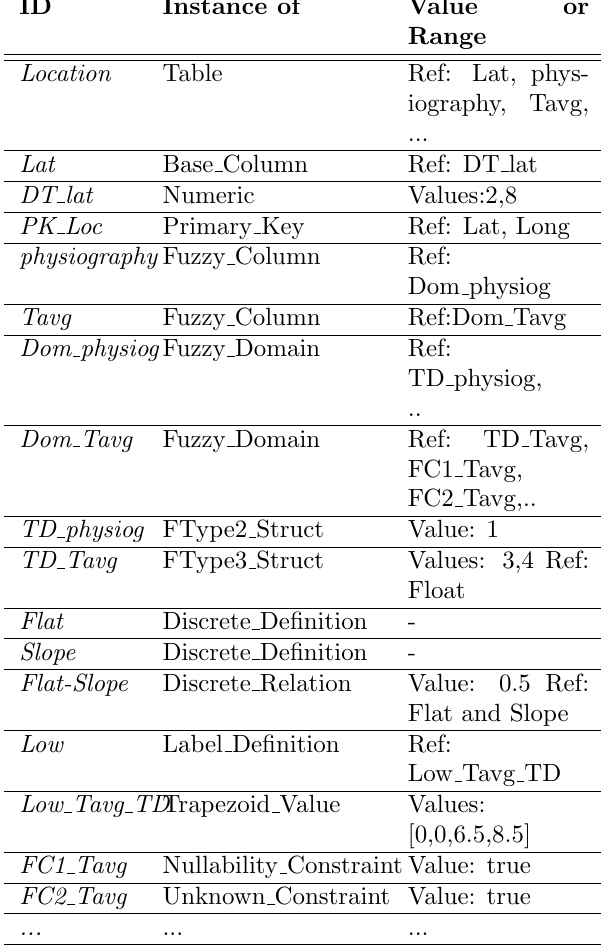
Table 2. Land ontology schema instances.